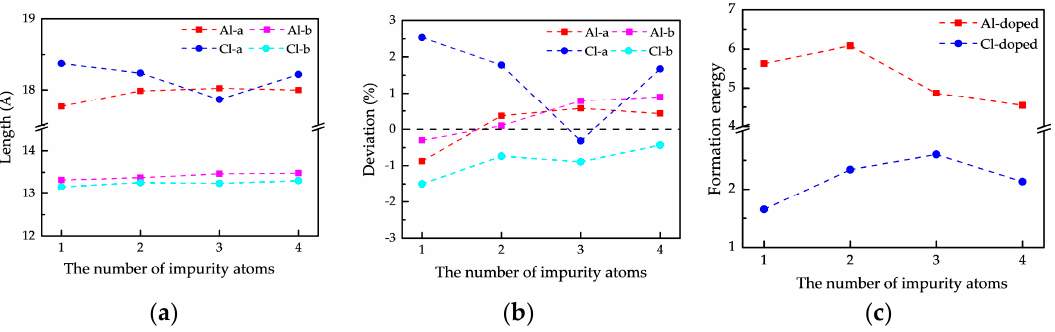
Figure 3. The structural parameters ( a ), geometrical deviations ( b ), and formation energies ( c ) of doped phosphorenes with different impurity